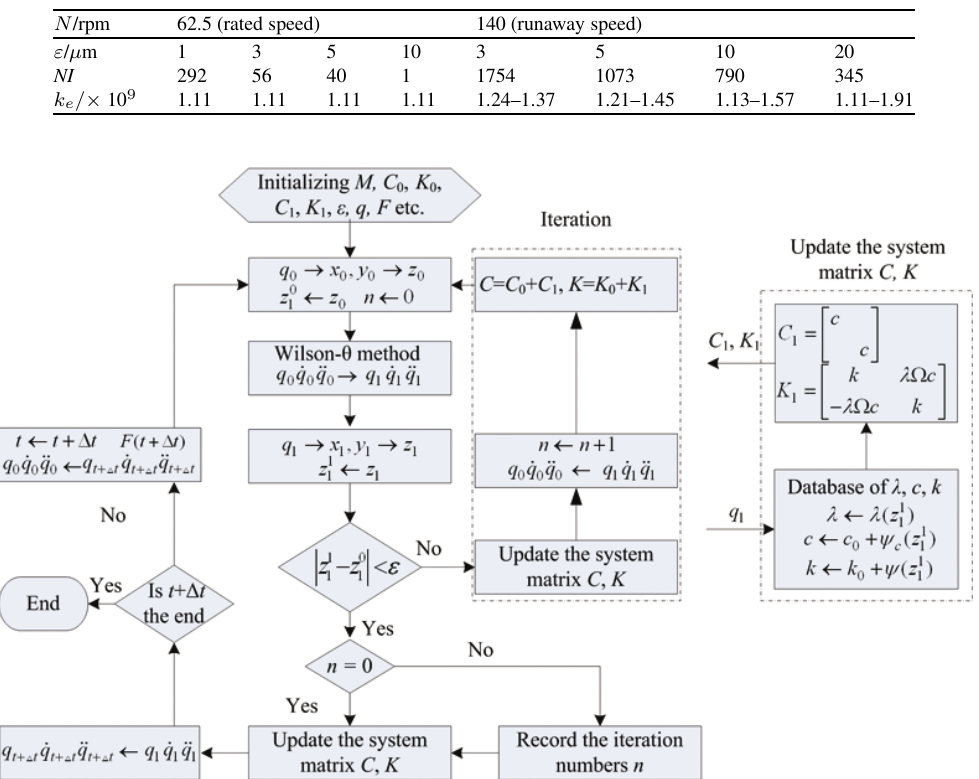
Table 1 Influence of ε on the simulation results (UGB). NI is the iteration number and k e is the equivalent stiffness